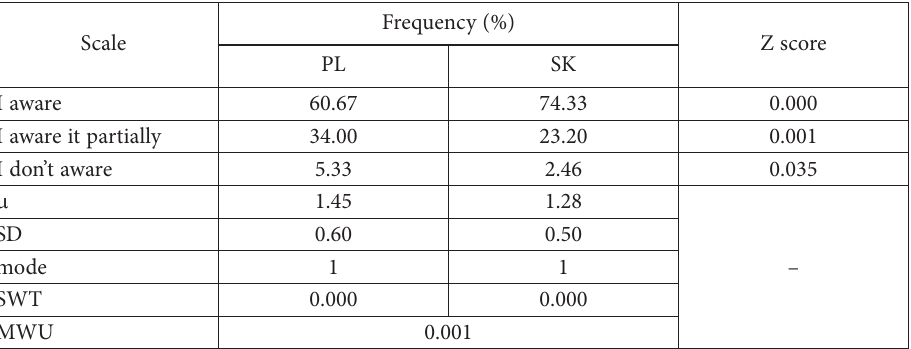
Table 2. The level of awareness regarding Industry 4.0